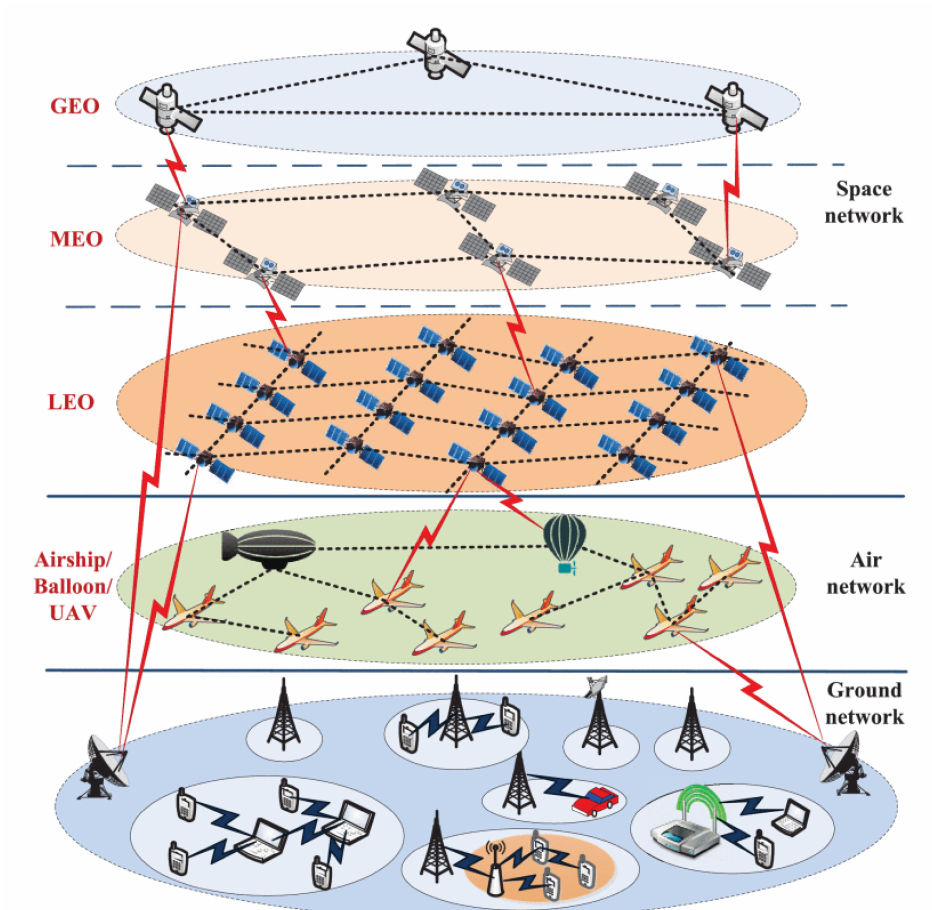
Figure 2. An architecture for space–air–ground-integrated network